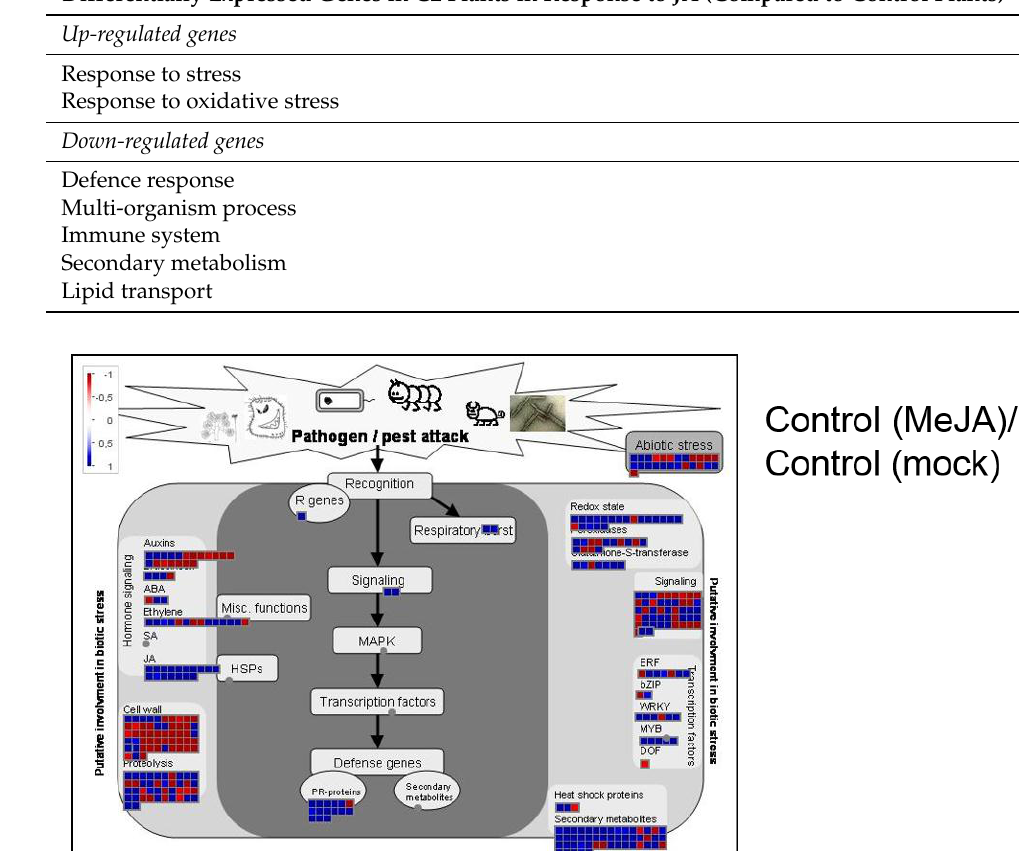
Figure 3. Cont. Figure 3.